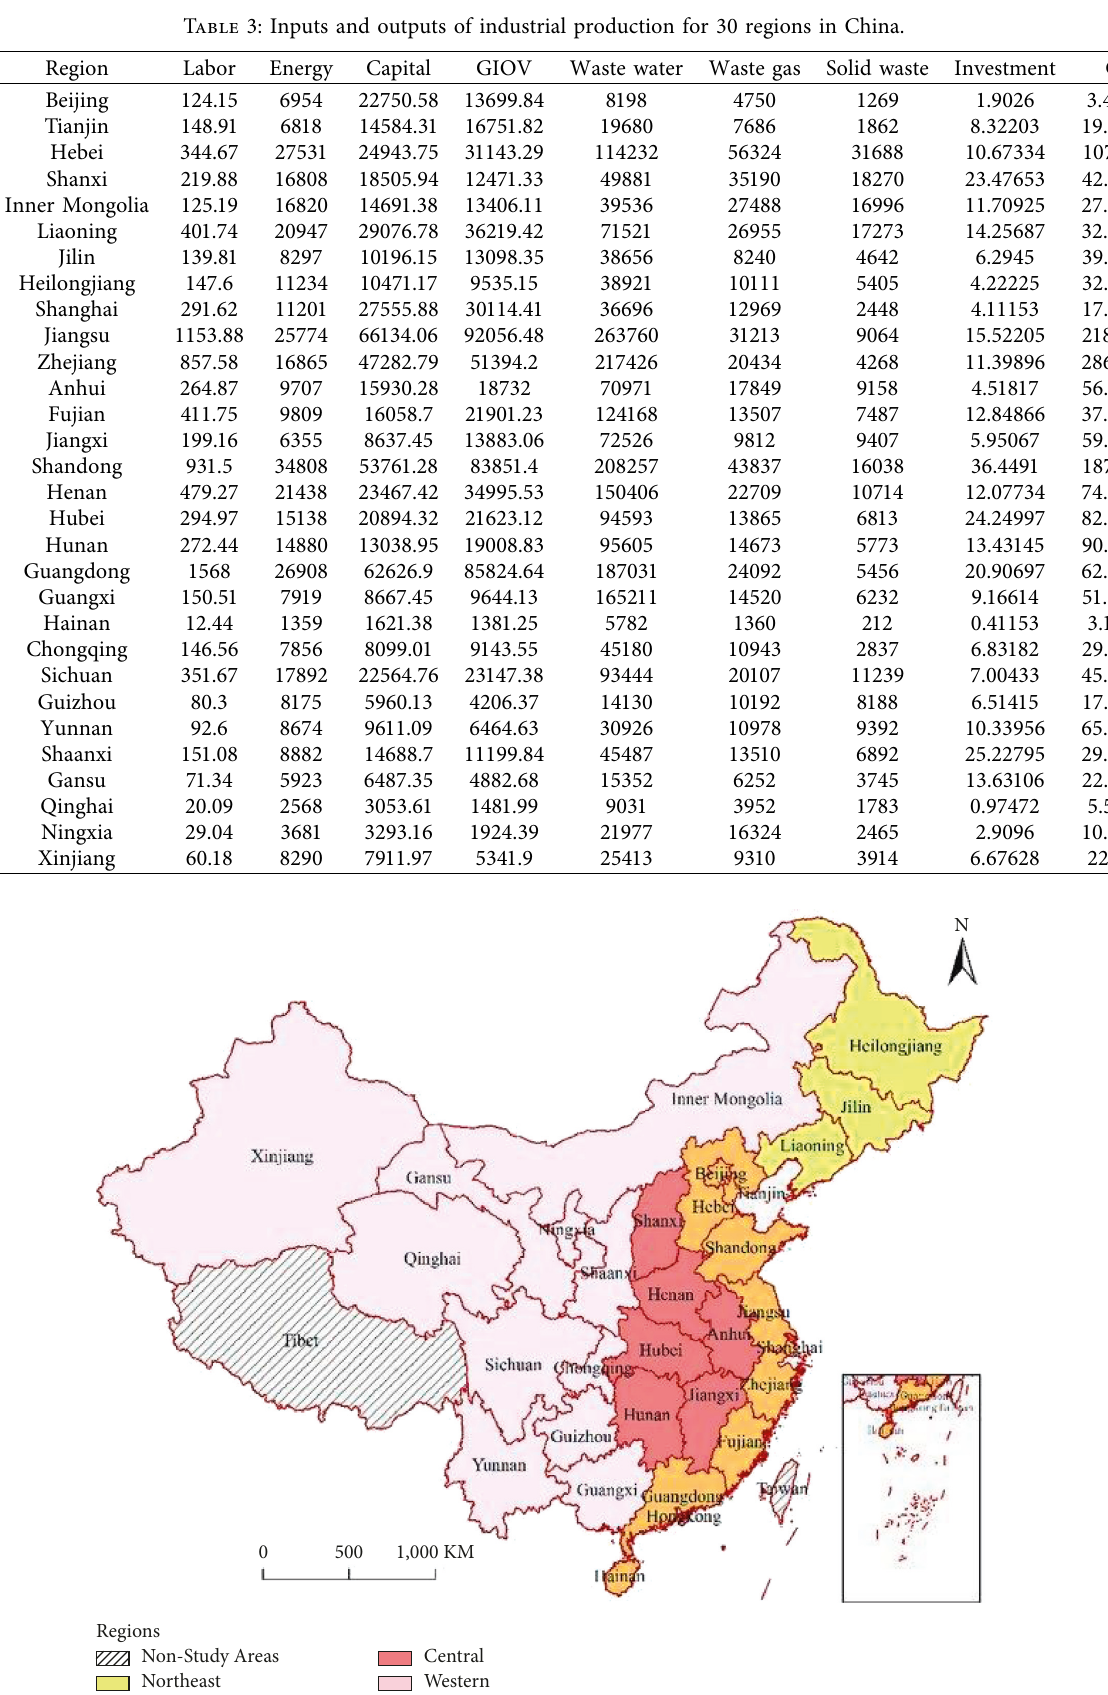
Figure 3: Four major economic regions of China.